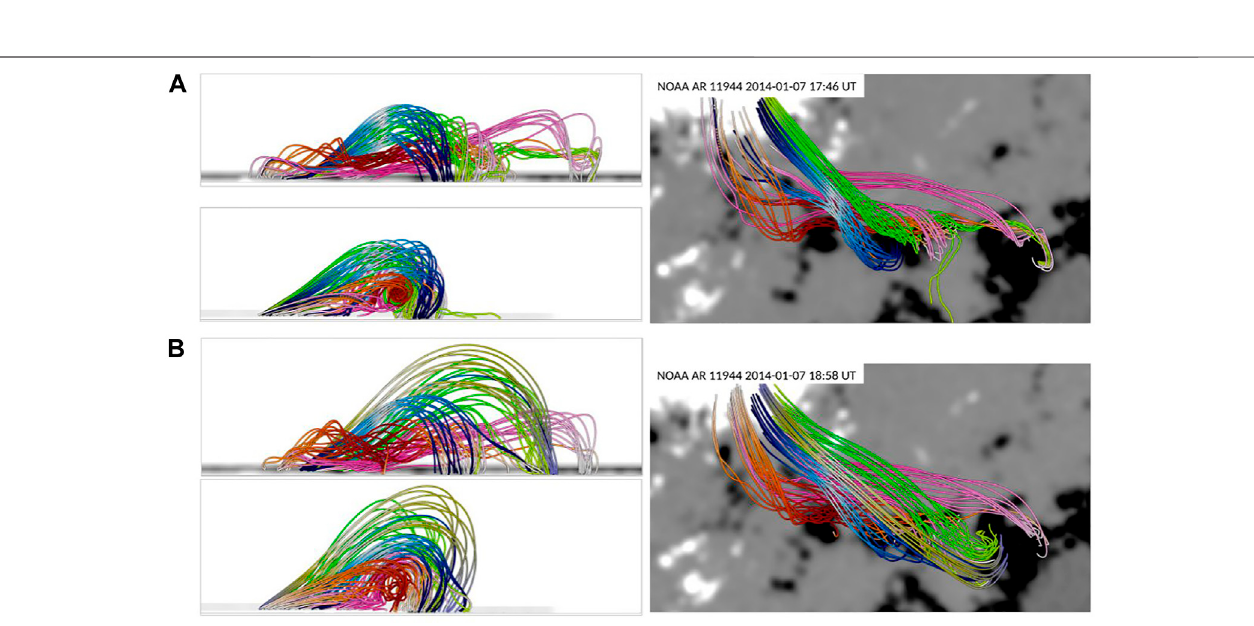
FIGURE 5 | Results of magnetic fi eld extrapolation using a pre- fl are 17:46 UT, (A) and post- fl are 18:58 UT, (B) magnetic fi eld measurements. The FOV shown is 140×70×70 ″ andislocatedat55 < x < 220and − 180 < y < − 80in Figure1 .Coloredlineshighlightvariousmagnetic fl uxsystemsassociatedwiththetwiststructures shown in Figure 4